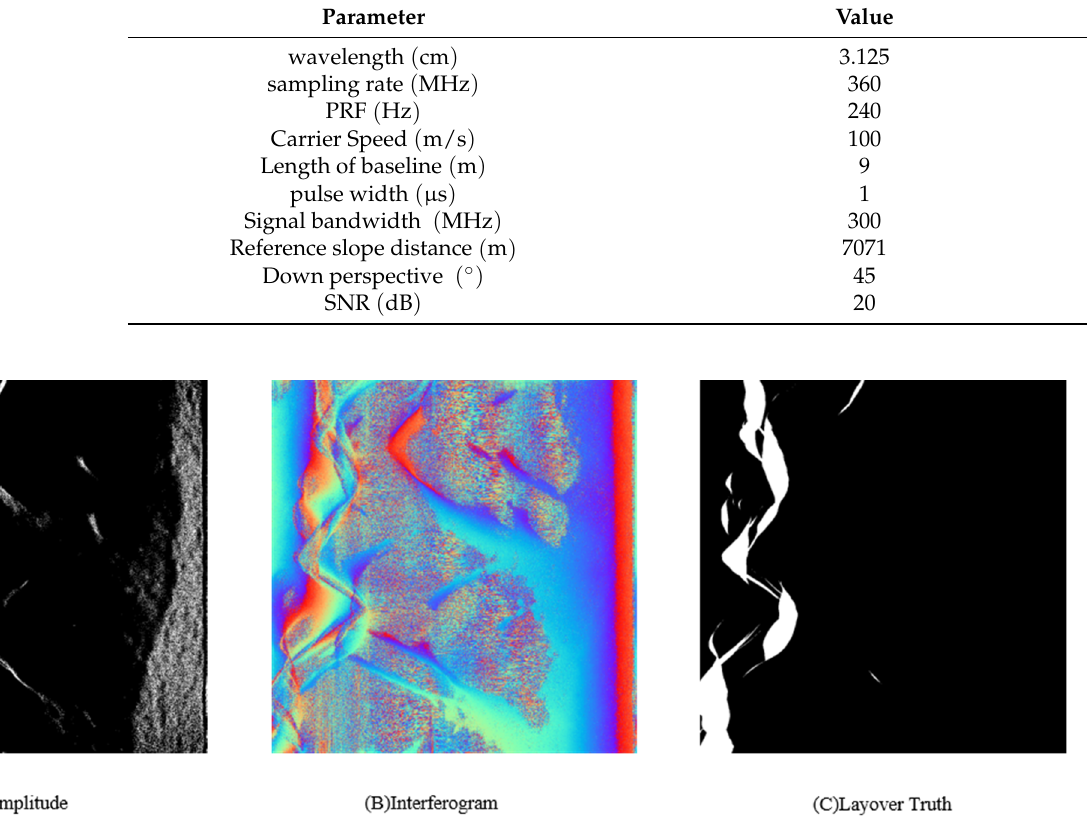
Figure 7. The simulation experiment data. ( A ) shows the amplitude of channel 1 signal, ( B ) shows the interferogram of two channels, and ( C ) shows the truth of the layover that is represented as the white part in the figure.